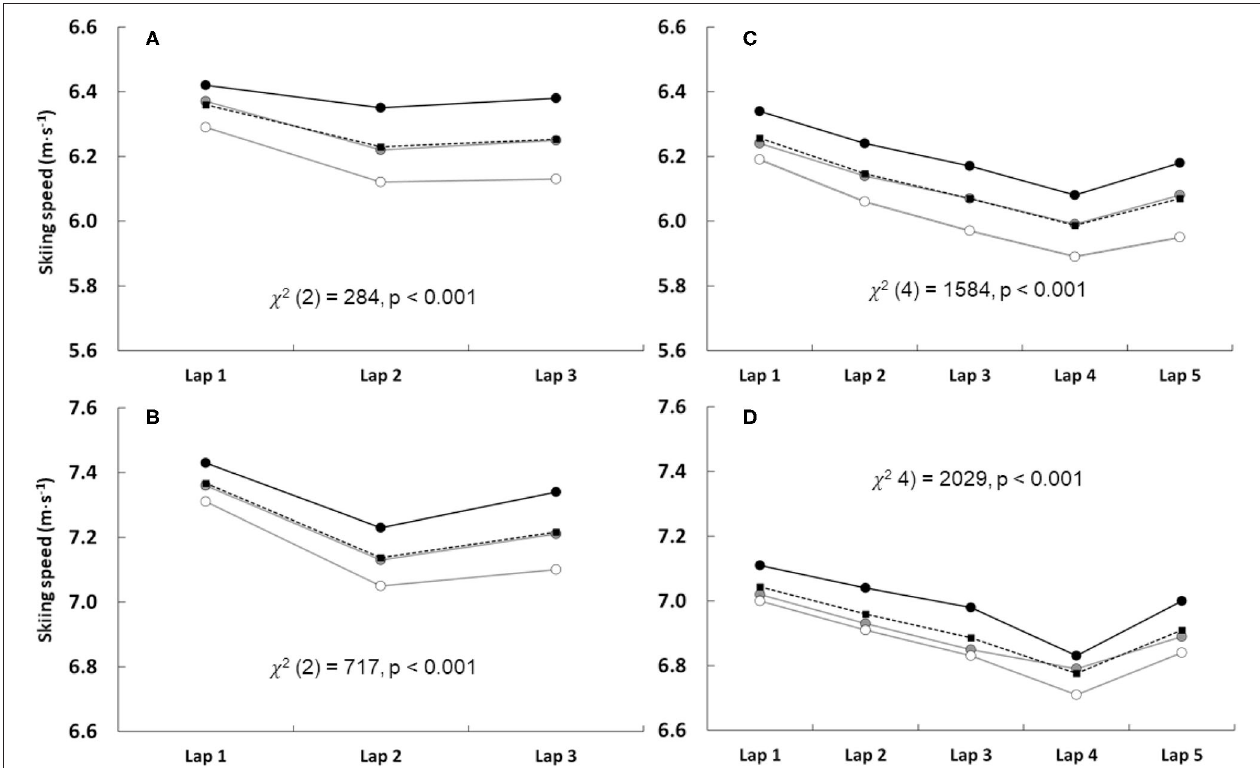
FIGURE 2 | The skiing speed during different laps in sprint and individual competitions for women [ (A) and (C) , respectively] and men [ (B) and (D) , respectively], including the overall (black dashed line, black squares) and groups of ranks 1–3 (black solid line, black filled circles), ranks 4–10 (gray solid line, gray filled circles,) and ranks 11–20 (gray solid line, white filled circles) during seasons from 2002/2003 to 2018/2019. Each data point represents the median of all competitions during each season for each group. Sprint (A,B) and individual (C,D) include 9–10 and 3–4 competitions during each season, respectively, except season 2018/2019 having only 2 individual